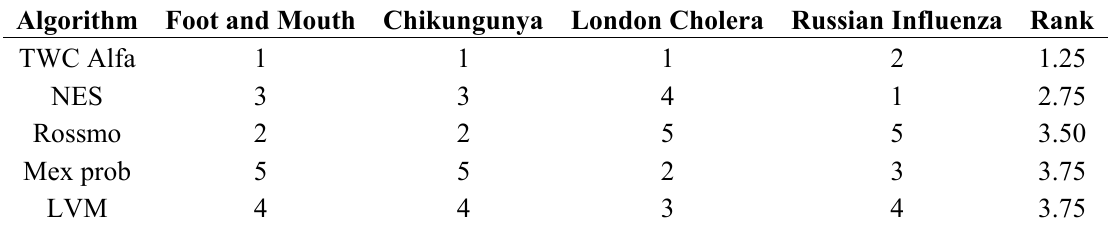
Table 5. The average rank of each algorithm in the four